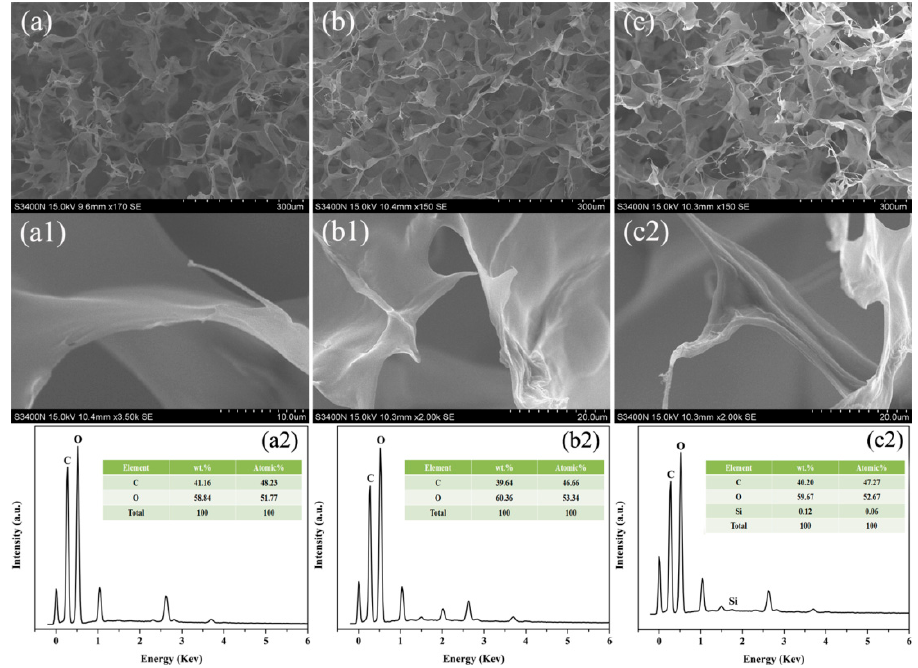
Figure 5. Scanning electron microscopy (SEM) images of the pure CNF ( a , a1 ), CNF/BTCA 10/1 ( b , b1 ), and Si-CNF/BTCA ( c , c1 ) aerogels. Energy dispersive X-ray spectroscopy(EDX) spectra of the pure CNF ( a2 ), CNF/BTCA 10/1 ( b2 ), and Si-CNF/BTCA ( c2 ) aerogels.